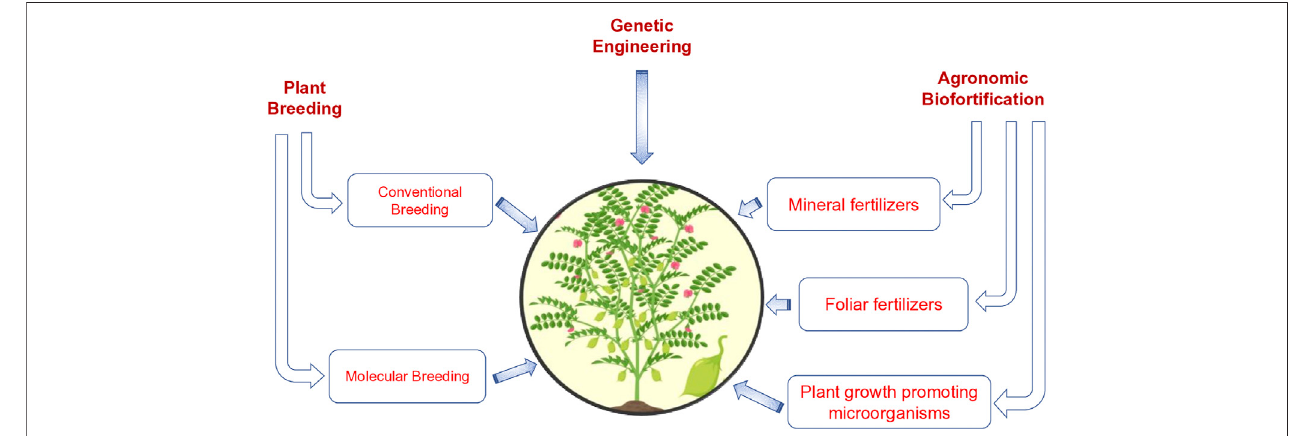
FIGURE 1 | Diagram showing the various approaches to bioforti fi ed chickpea.